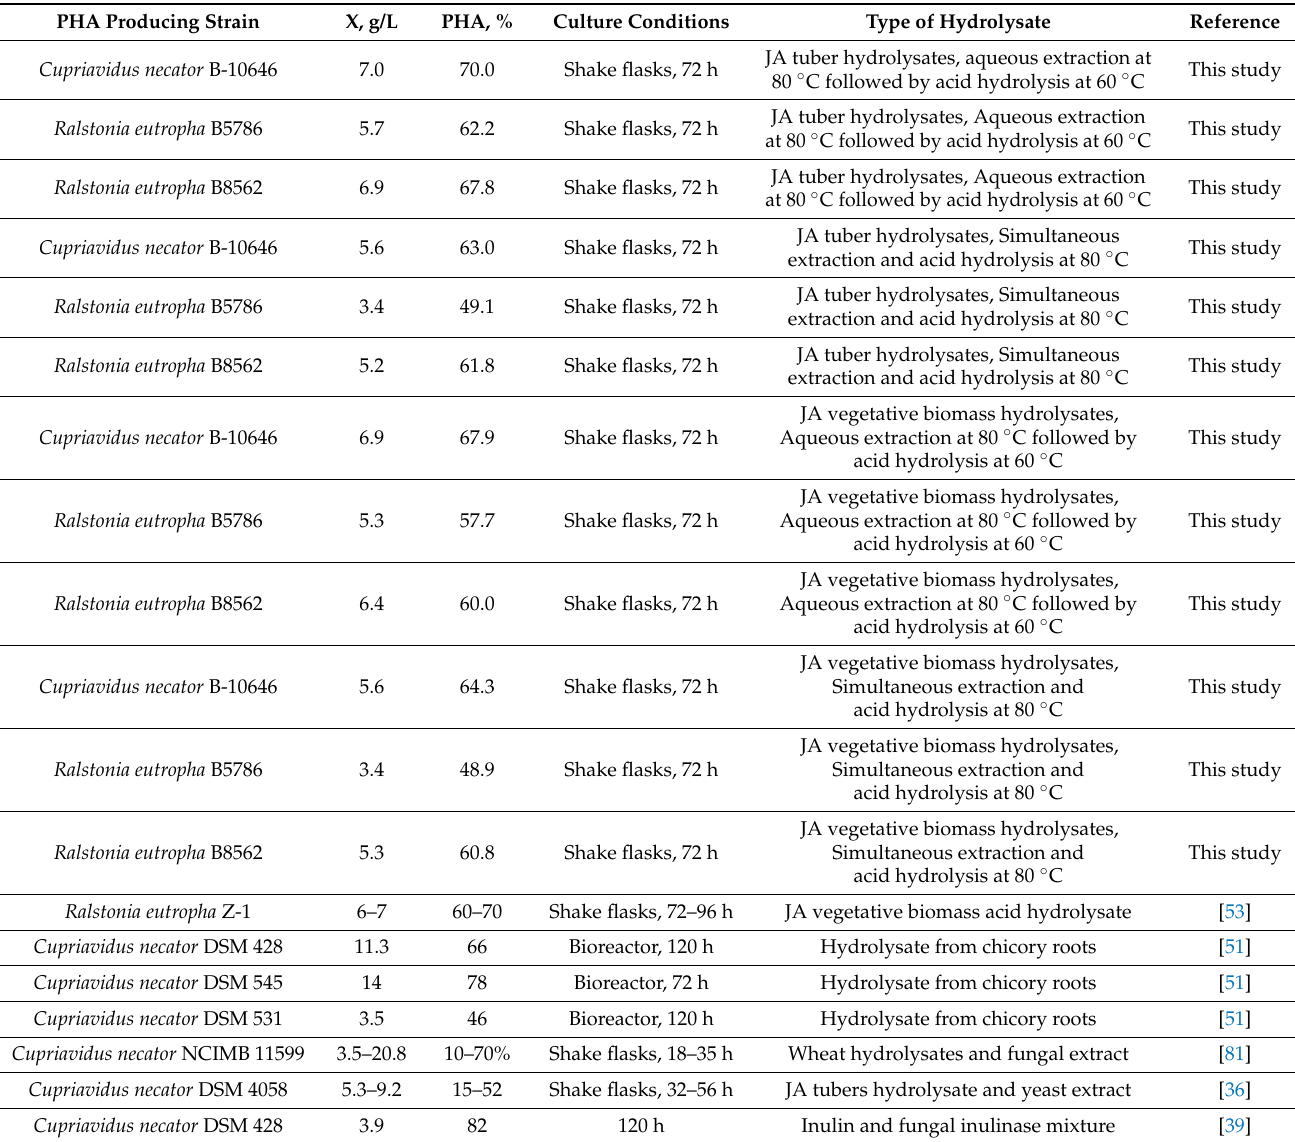
Table 4. Culture conditions, biomass concentrations, and PHA contents produced by different bacterial strains cultivated on